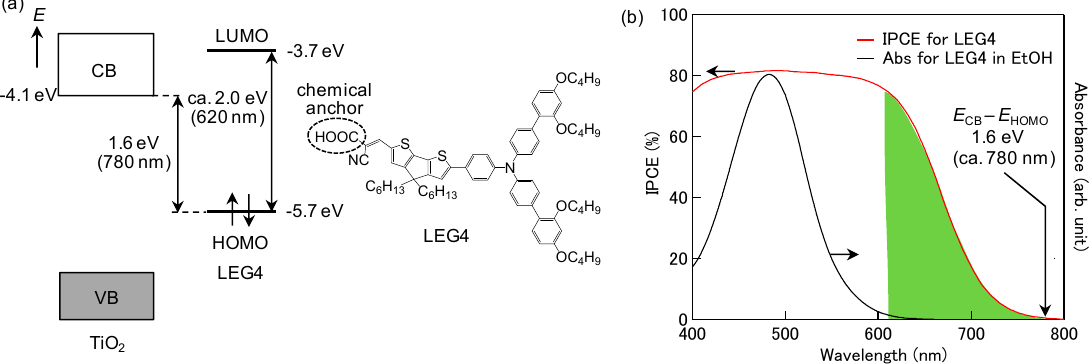
Figure 10. ( a ) Energy level diagram of TiO 2 and LEG4 along with the molecular structure and ( b ) absorption spectrum of LEG4 in ethanol and IPCE spectrum of TiO 2 -LEG4 DSSC. Adapted with permission from Reference 3. Copyright 2018 American Chemical Society.